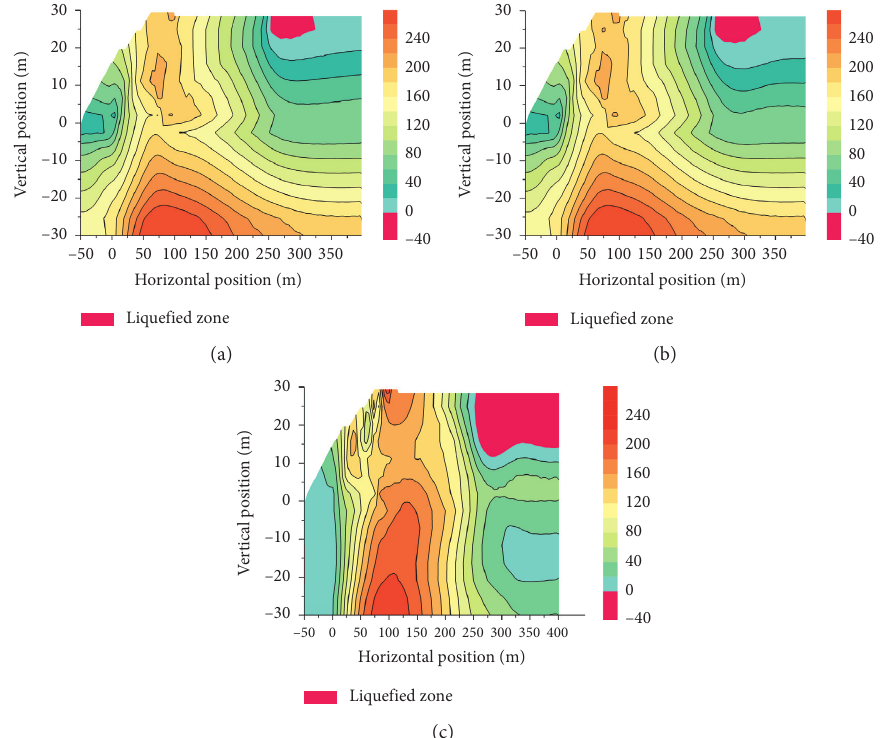
Figure 16: Contour of effective stress and range of liquefied area of ash storage site under three input earthquakes ( L � 0.10g. (b) a � 0.20g. (c) a � (a) a max max max